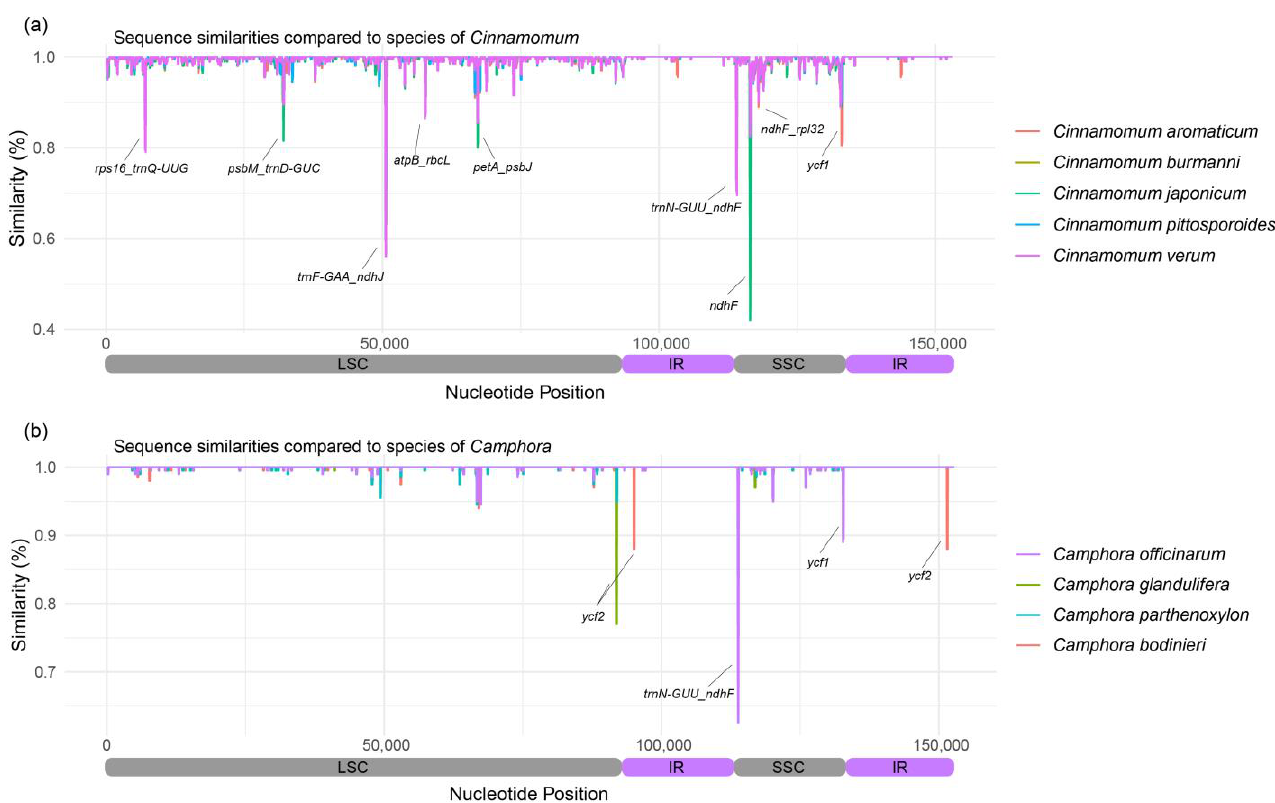
Figure 4. Similarity analysis of the plastome of Cinnamomum guizhouense C.Y. Deng et al. ( a ) The similarity plot of the plastome of Cinnamomum guizhouense in comparison with the sampled species of Cinnamomum Schaeff. ( b ) The similarity plot of the plastome of Cinnamomum guizhouense in comparison with the sampled species of Camphora Fabr. Regions with similarity lower than 90% are indicated.